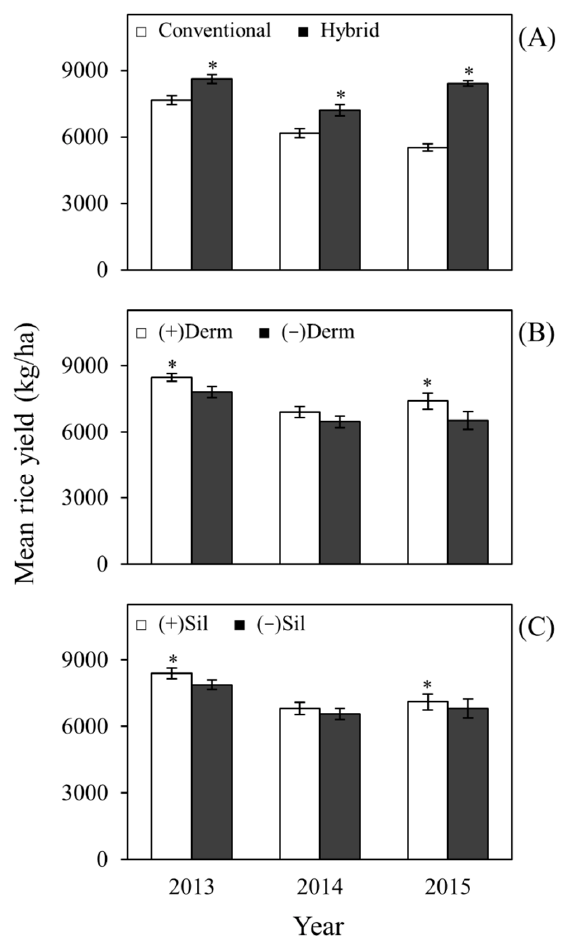
Figure 4. Main effects of variety, Dermacor seed treatment, and silicon amendment on rice yields (kg/ha ± SEM). ( A ) main effect of variety; ( B ) main effect of Dermacor treatment; ( C ) main effect of silicon amendment in 2013, 2014, and 2015. For each year, bars accompanied by asterisks designate significant difference ( P < 0.05; Tukey’s HSD). The bars represent standard error of means (SEM).